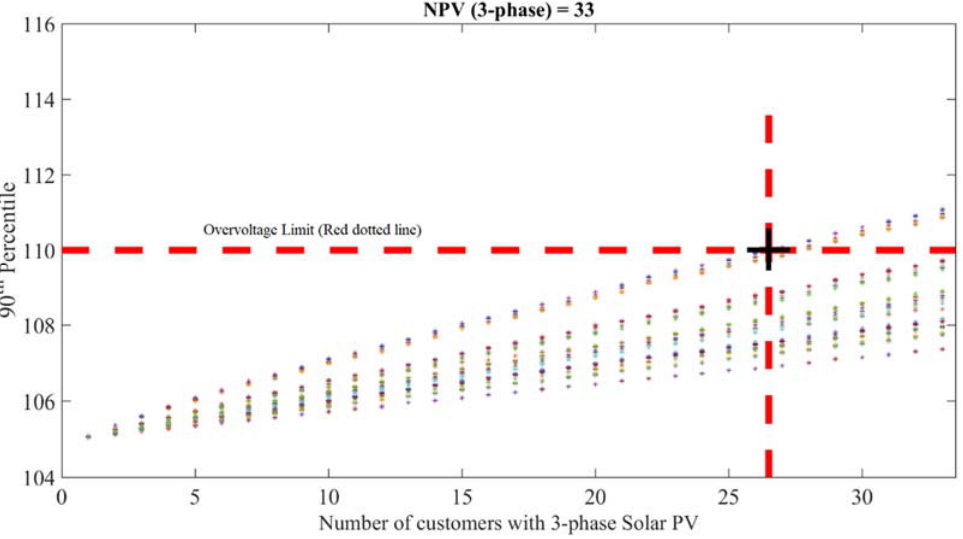
Figure 5. The 90th percentile values for the customers’ voltages in Figure 4 are applied to obtain the hosting capacity for the distribution network.